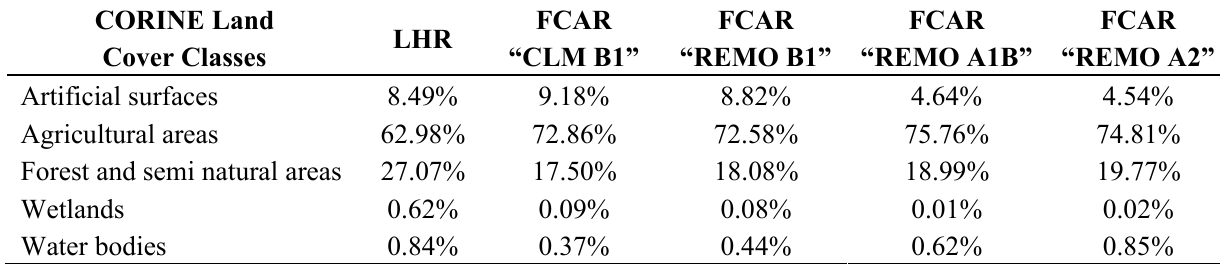
Table 1. Comparison of CORINE land cover classes (main categories) between the LHR and the